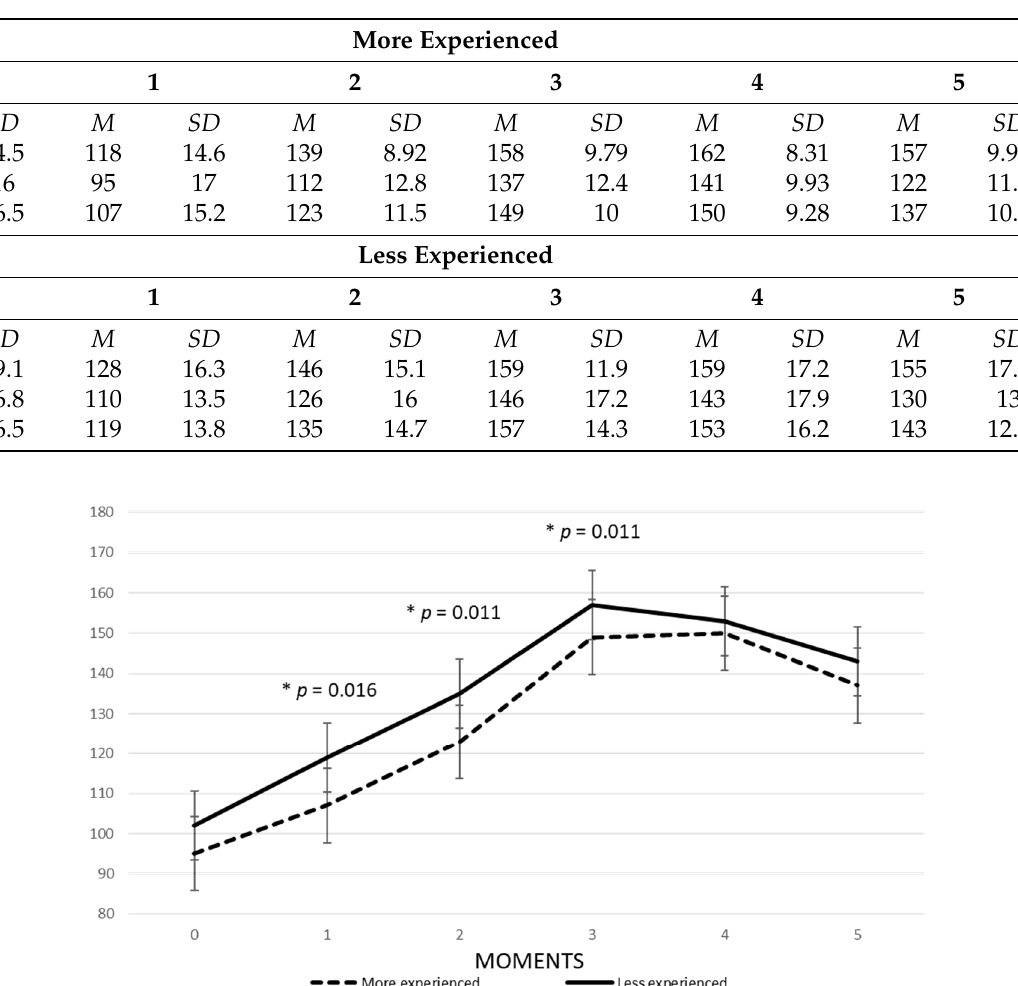
Table 2. HR at the moments of a jump in relation to level of experience.